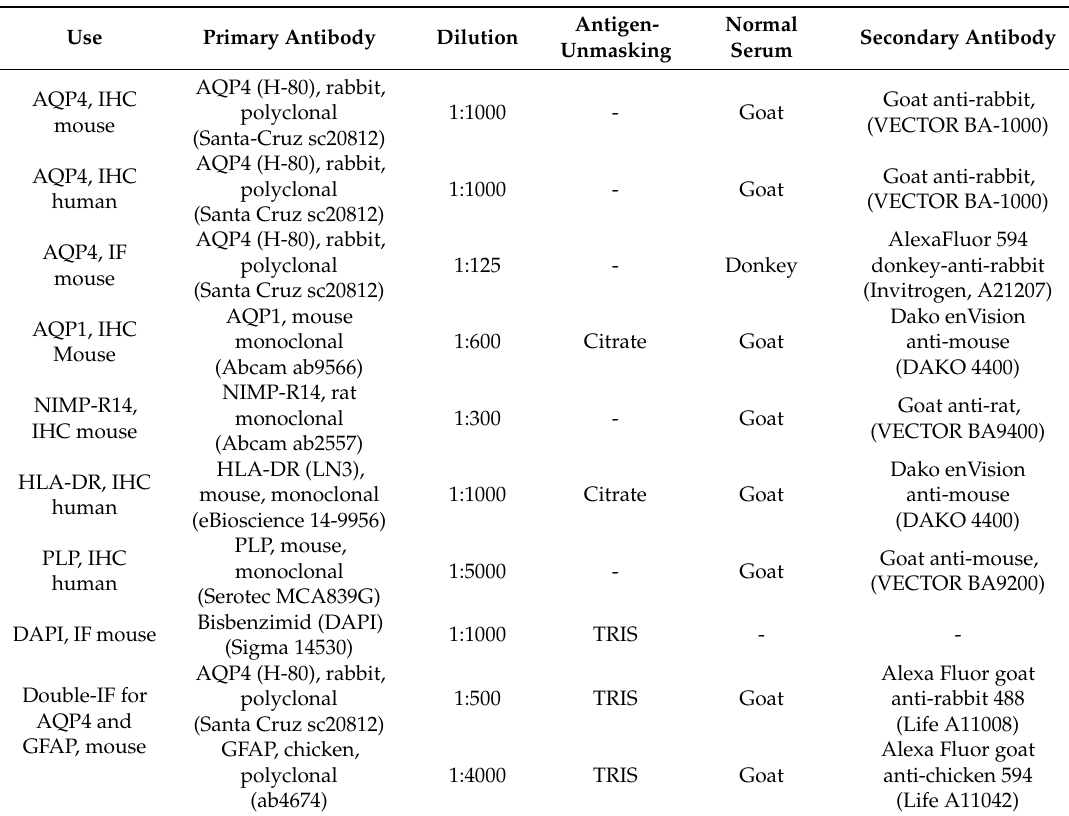
Table A2. Antibodies for immunohistochemistry and immunofluorescence